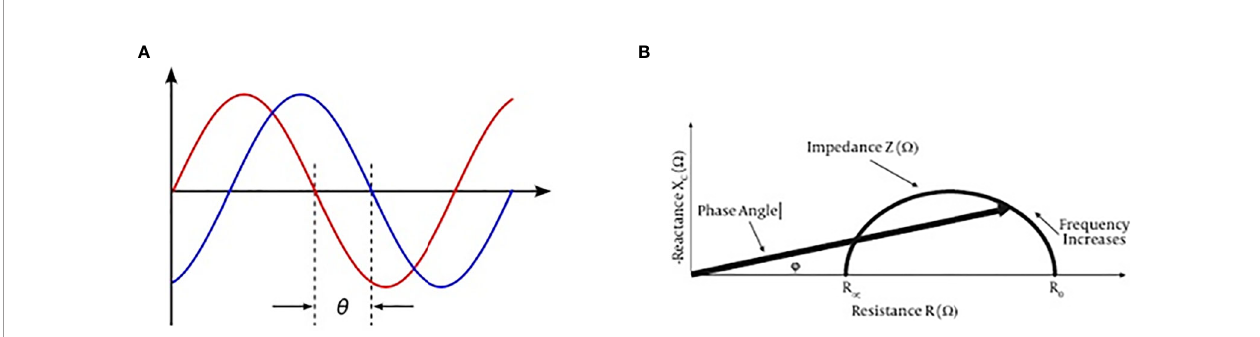
FIGURE 1 | BIA test current voltage and phase angle de fi nition. (A) Phase angle consists in a ratio between current out-of-phase and current phase, and it may be expressed by an angle value ( f ). (B) Reactance and resistance measurement by BIA test may express a phase angle